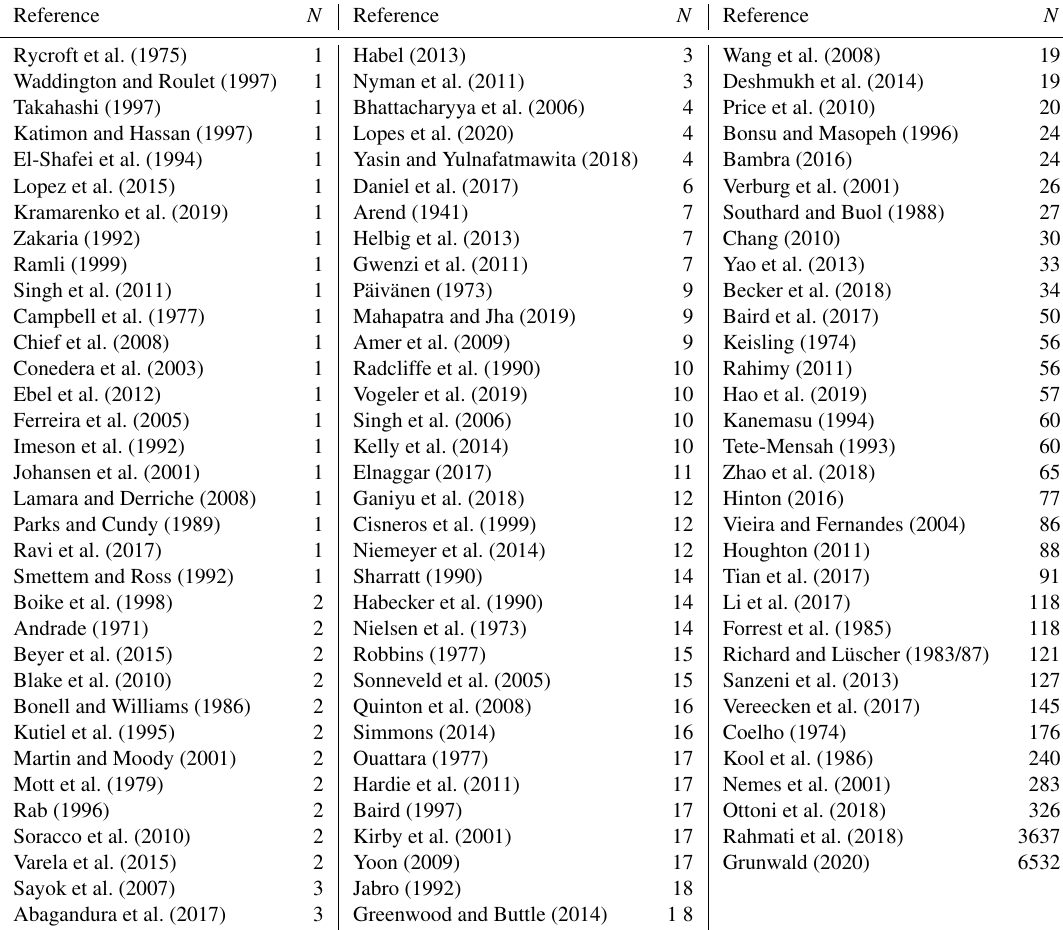
Table 1. List of articles, digitized K sat datasets, and the number of points ( N ) per dataset used to generate the SoilKsatDB.